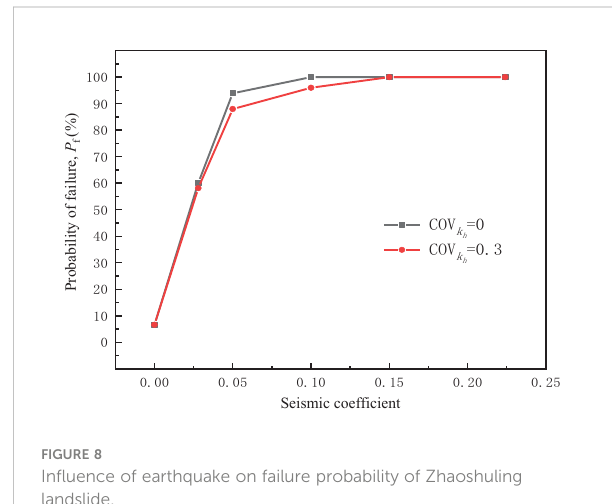
FIGURE 8 In fl uence of earthquake on failure probability of Zhaoshuling